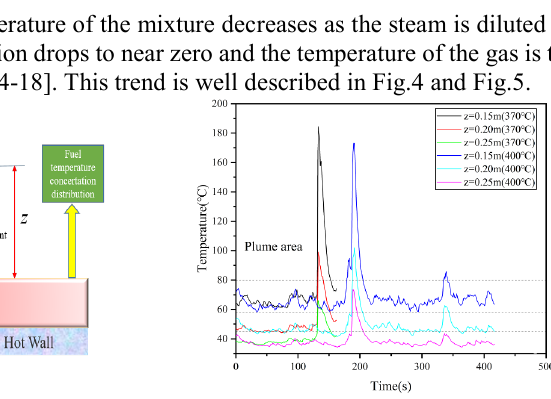
Fig. 4. Empirical modeling of minimum hot surface ignition temperature for spilled fuel.